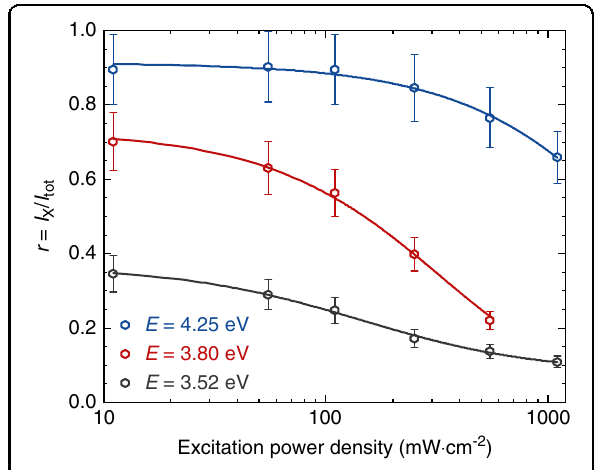
Fig. 10 Low temperature ( T = 5 K) evolution of the I X /I tot ratio as a function of excitation power density for various QD emission energies. Solid lines serve as a guide to the